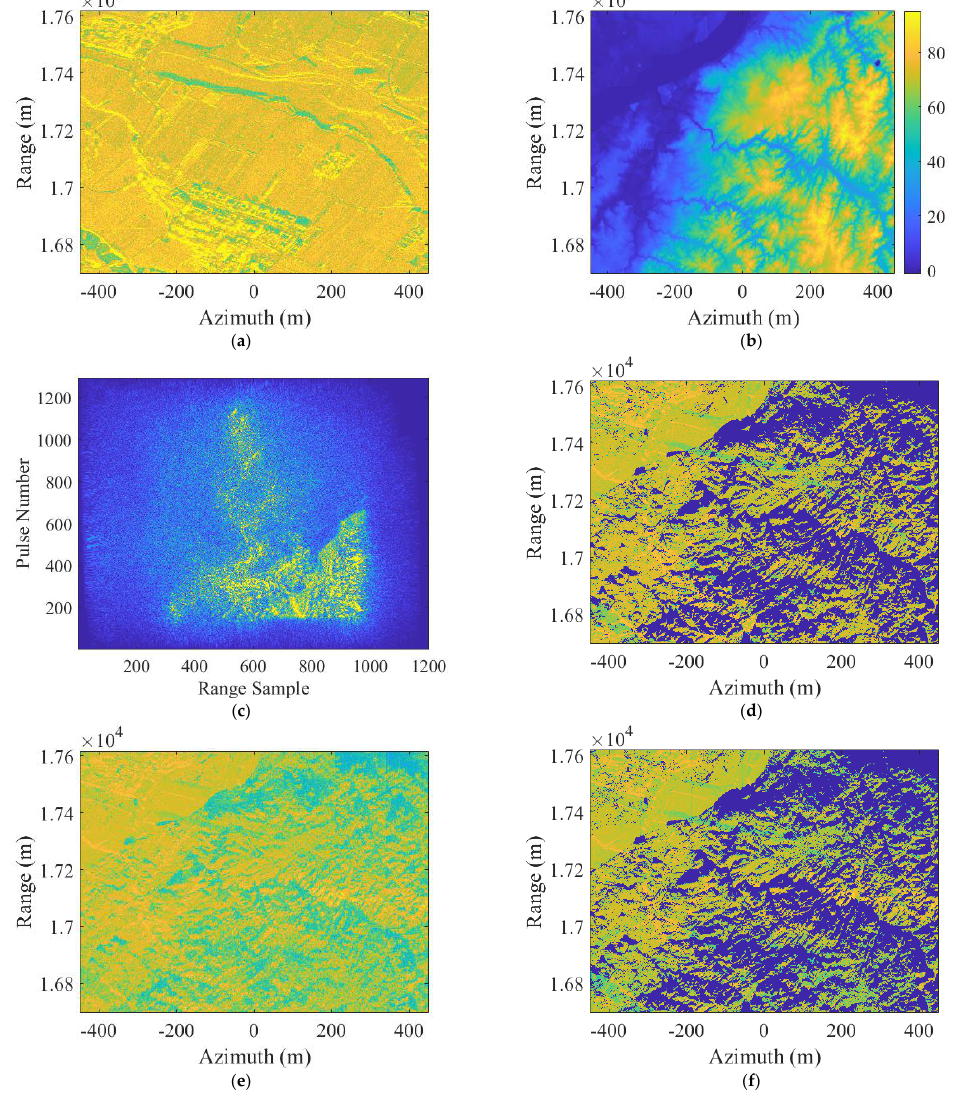
Figure 13. Scenario experiment results. ( a ) Real SAR imaging. ( b ) Measured DEM data. ( c ) Simulated SAR echo signal. ( d ) Theoretical occlusion result. ( e ) SAR imaging result of the classical BPA. ( f ) SAR imaging result of the proposed Topo-BPA.